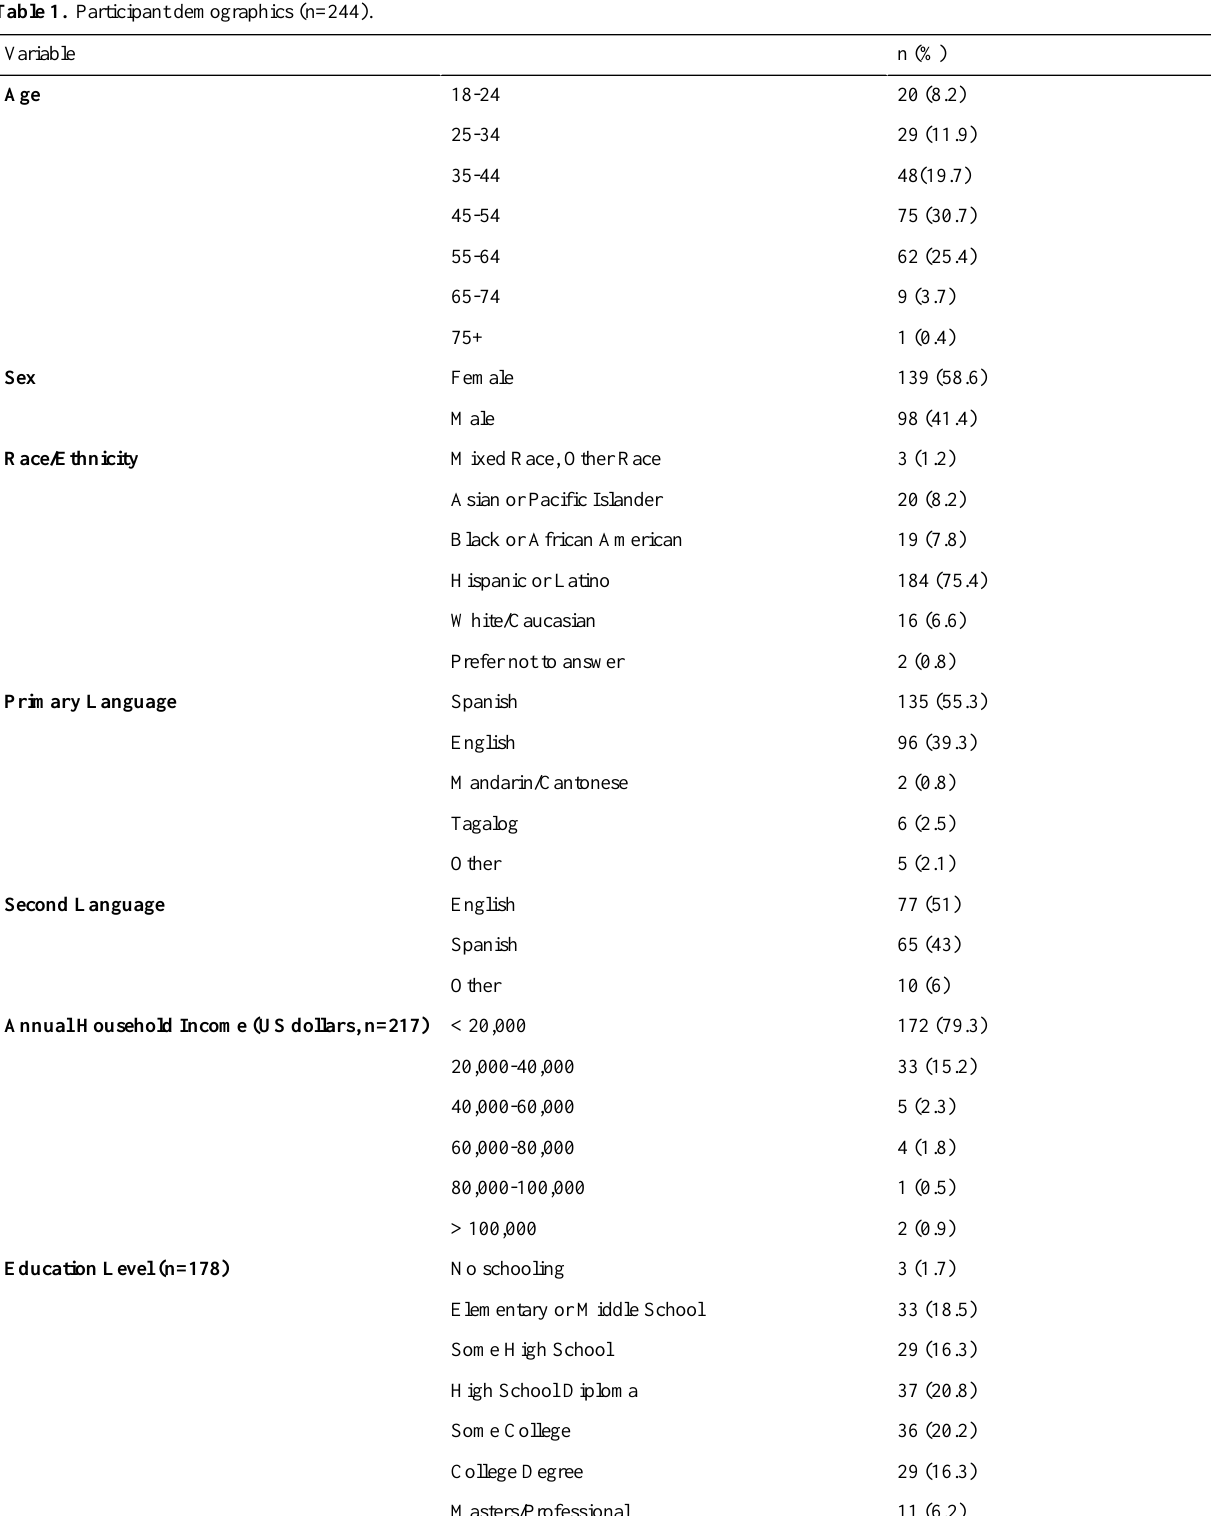
Table 1. Participant demographics